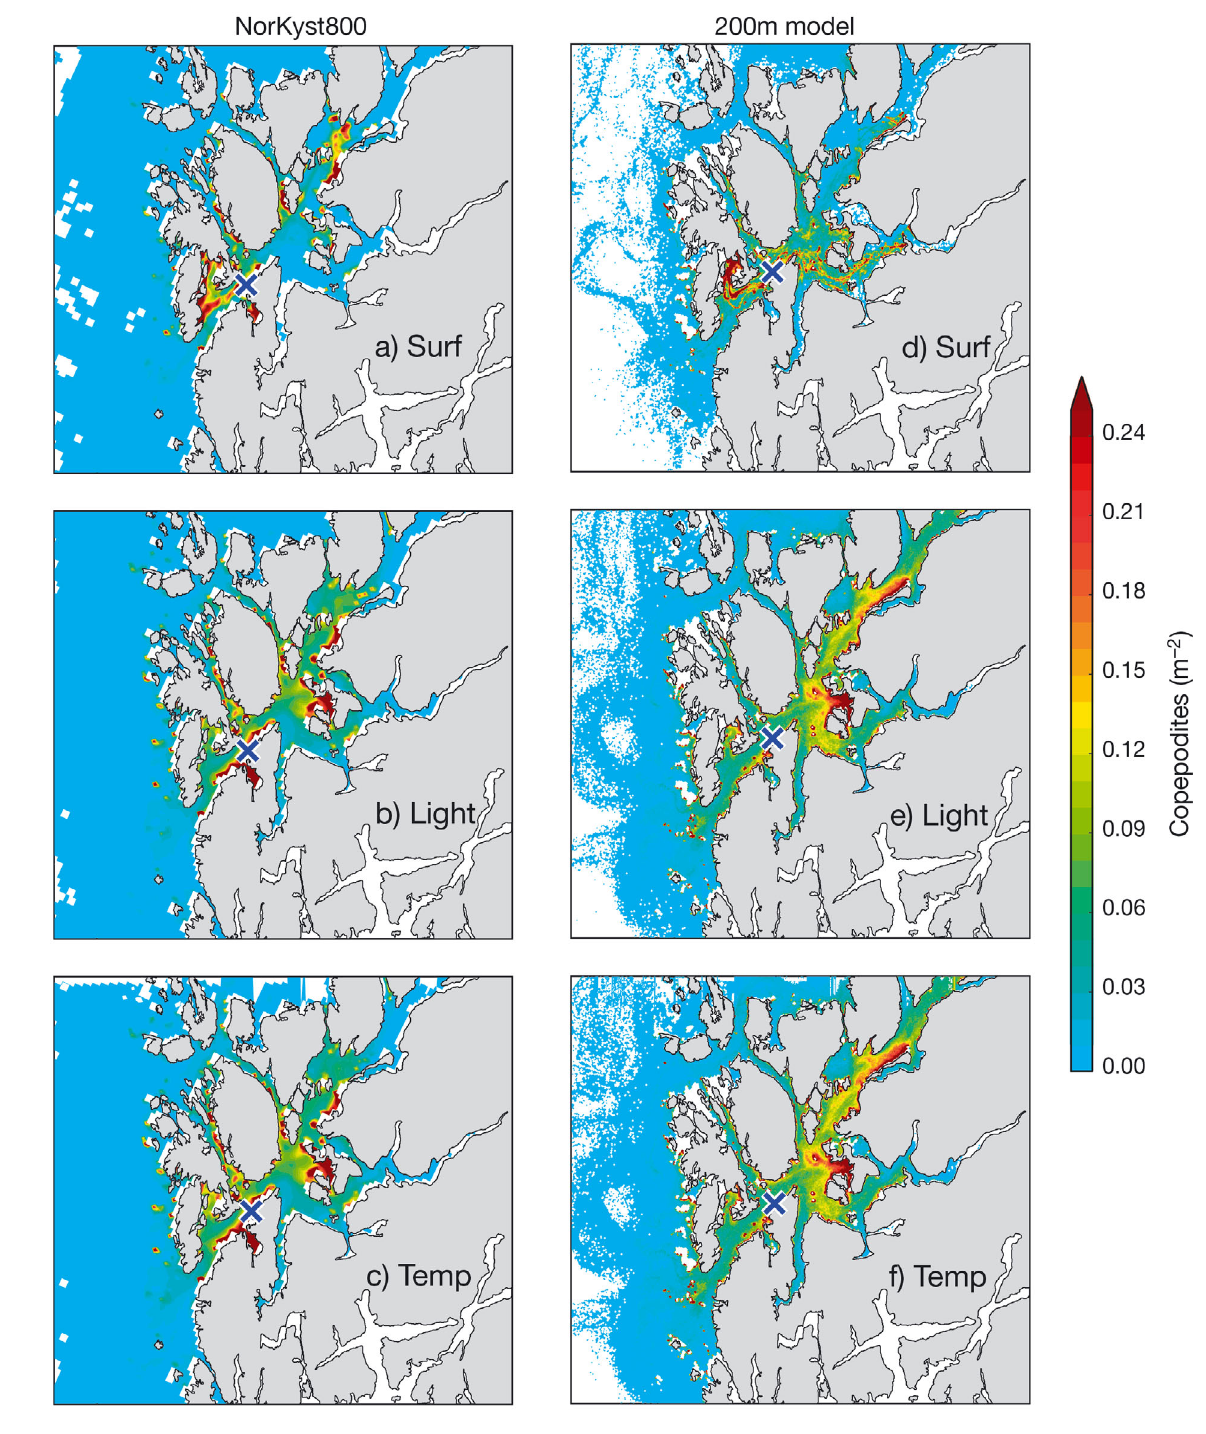
Fig. 7. Simulated horizontal dispersion of Lepeophtheirus salmonis in the Hardangerfjord during 1−31 May 2009 based on cur- rent fields from (a−c) the model NorKyst800 and (d−f) the 200 m resolution fjord model. Plots show vertical and time-integrated distribution of copepodite particles with different behaviours: (a,d) fixed at the surface (Surf), (b,e) vertical migration con- trolled by light and salinity (Light), and (c,f) temperature-controlled vertical migration (Temp). Blue crosses indicate release locations of particles. Particles were counted in grid cells of 800 × 800 m (lefthand panels) and 200 × 200 m (righthand panels), and divided by the cell